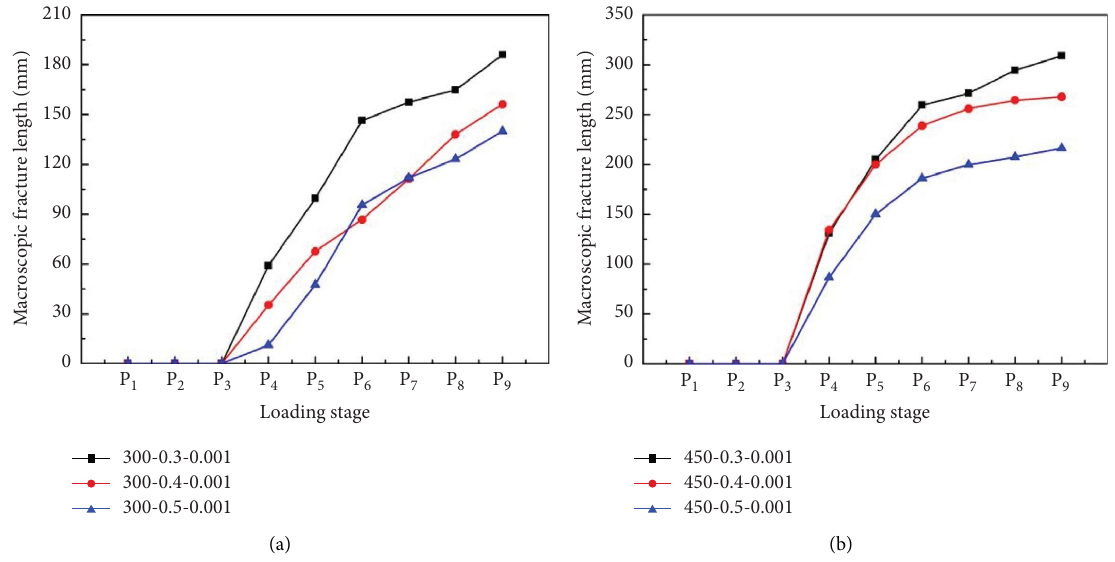
Figure 11: Te variation of macrocrack with loading stage. (a) WS300. (b) WS450.